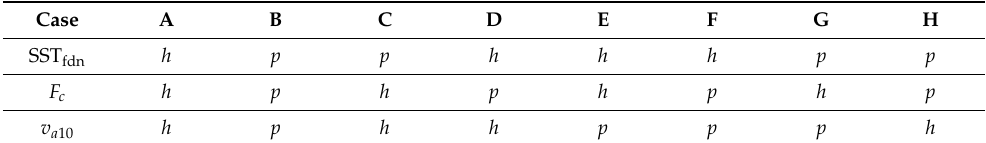
Table 8. Simulation cases and allocated